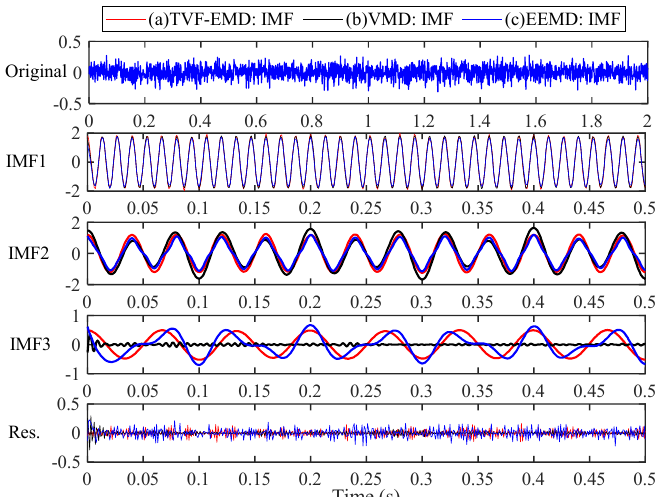
Figure 7. ( a ) Simulated signal y ( t ) and its frequency-domain waveform, and ( b ) its three components and noise signal.